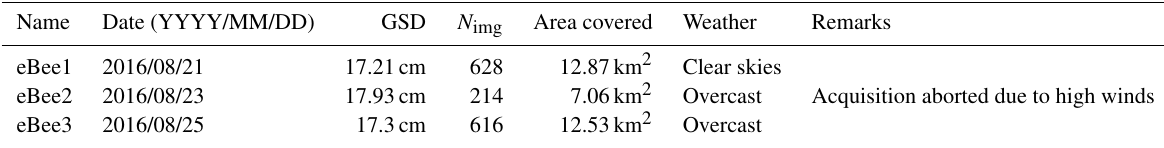
Table 3. Overview of acquisitions using the UAV during the 2016 field campaign. Date of acquisition is listed together with the average ground sampling distance (GSD), number of images acquired ( N img ) and the area